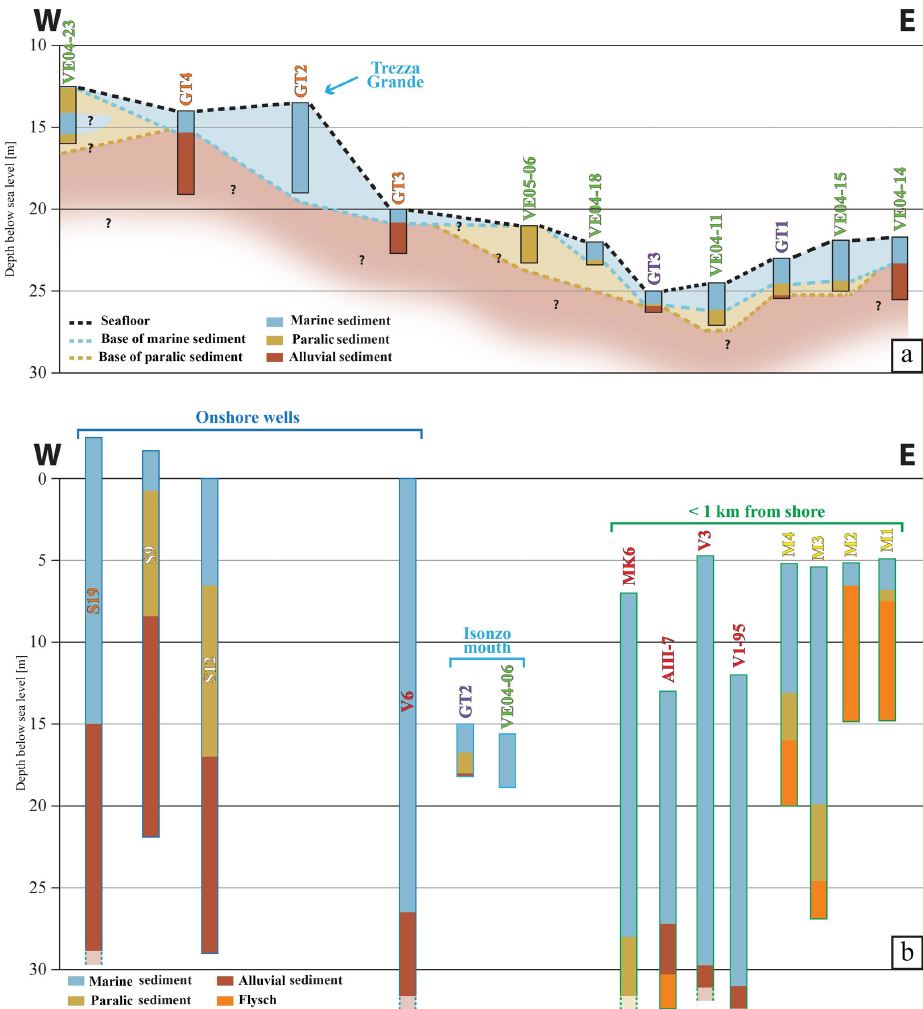
Figure 2. Simplified stratigraphy of all the cores and wells used in this study (Table 1; for details see Ogorelec et al., 1981, 1991, 1997; Marocco et al., 1984; Marocco, 1989; Gordini et al., 2002; Covelli et al., 2006; Romeo, 2009; Trincardi et al., 2011b; Zecchin et al., 2015). Note that the distance between the cores/wells is not in scale, (a) a simplified W–E stratigraphic profile of the cores located in the central part of the Gulf of Trieste; (b) wells and cores used in the study that were not suitable for the stratigraphic profile due to their location or proximity to the shore or fluvial sedimentary sources (see Figs. 4 and 5 for location). Wells outlined in dark blue are located onshore. Cores outlined in bright blue are located in close proximity of the present-day Isonzo river mouth. Cores outlined in green are located less than 1km from the shoreline. Dashed bottoms of wells indicate that their whole stratigraphy is not illustrated in the figure and that the reader should refer to the original publications for further